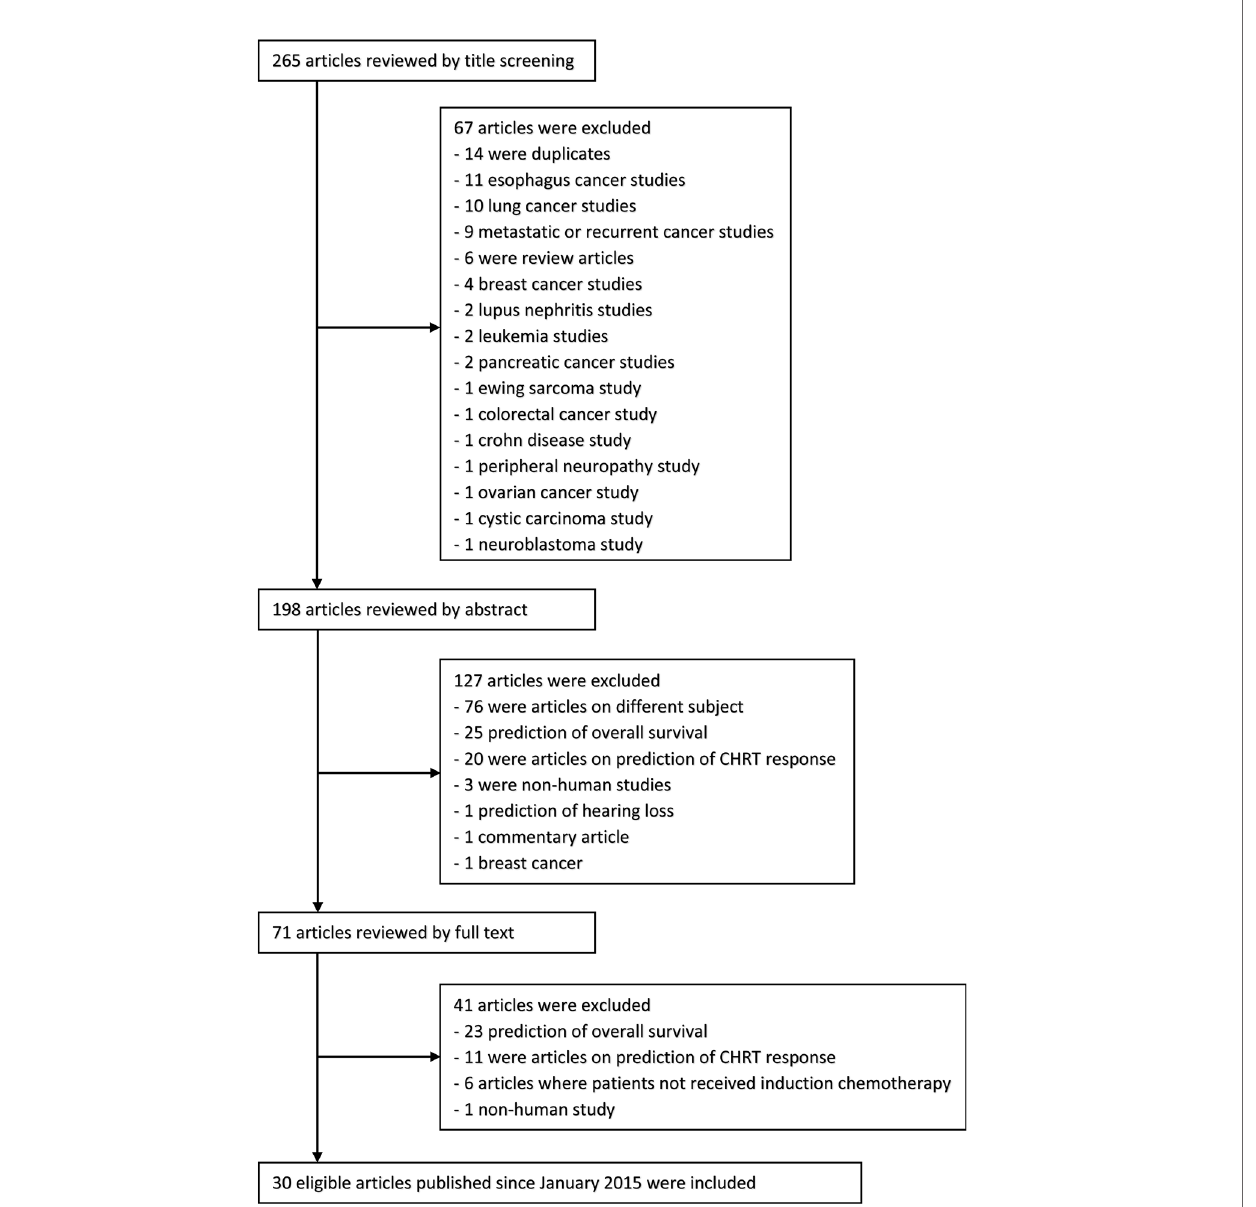
FIGURE 1 | The fl ow diagram of the selection